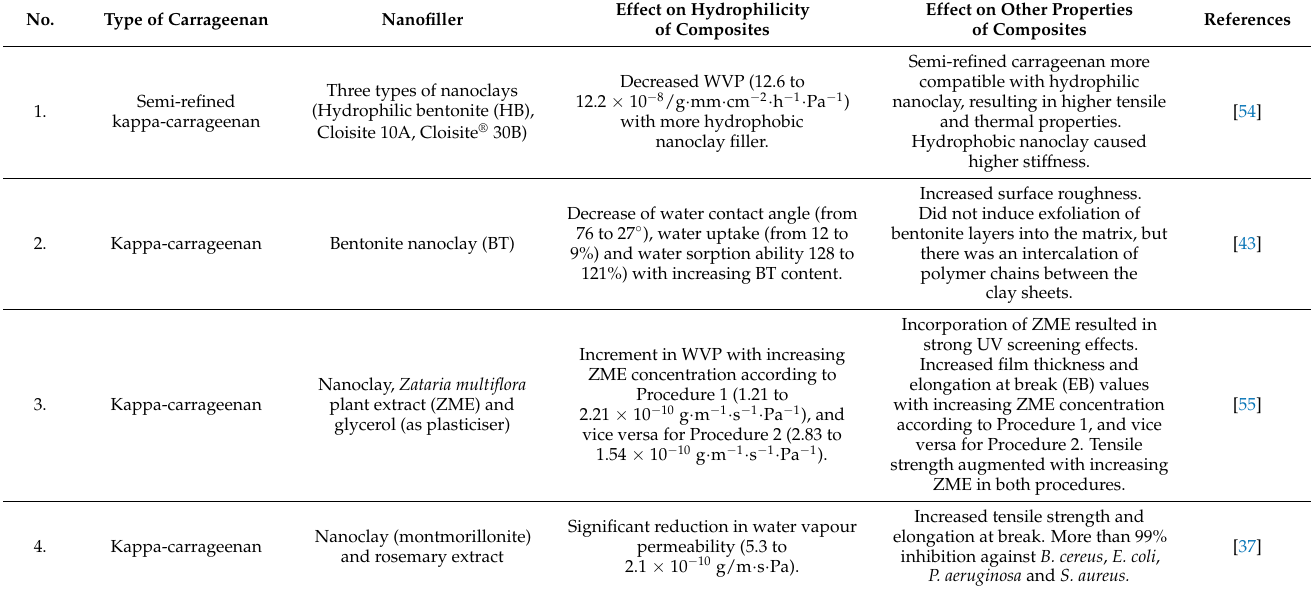
Table 4. Effect of refined vs. semi-refined carrageenan with nanoclays.